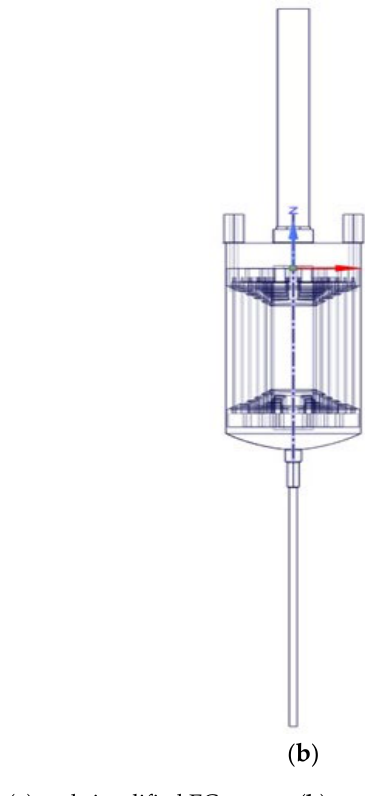
Figure 2. Shaded original design ( a ) and simplified EC reactor ( b ).